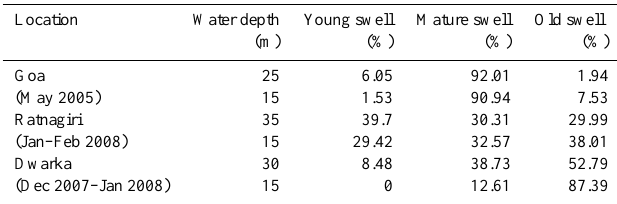
Table 4. Distribution of young, mature and old swells along the west coast of